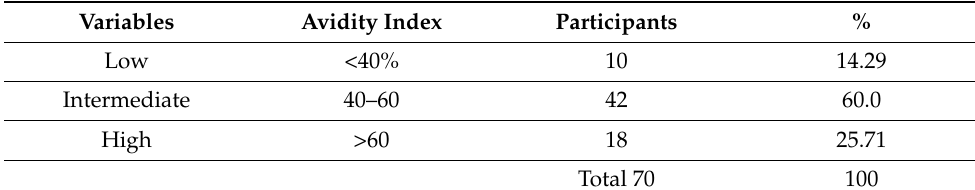
Table 3. IgG avidity index among